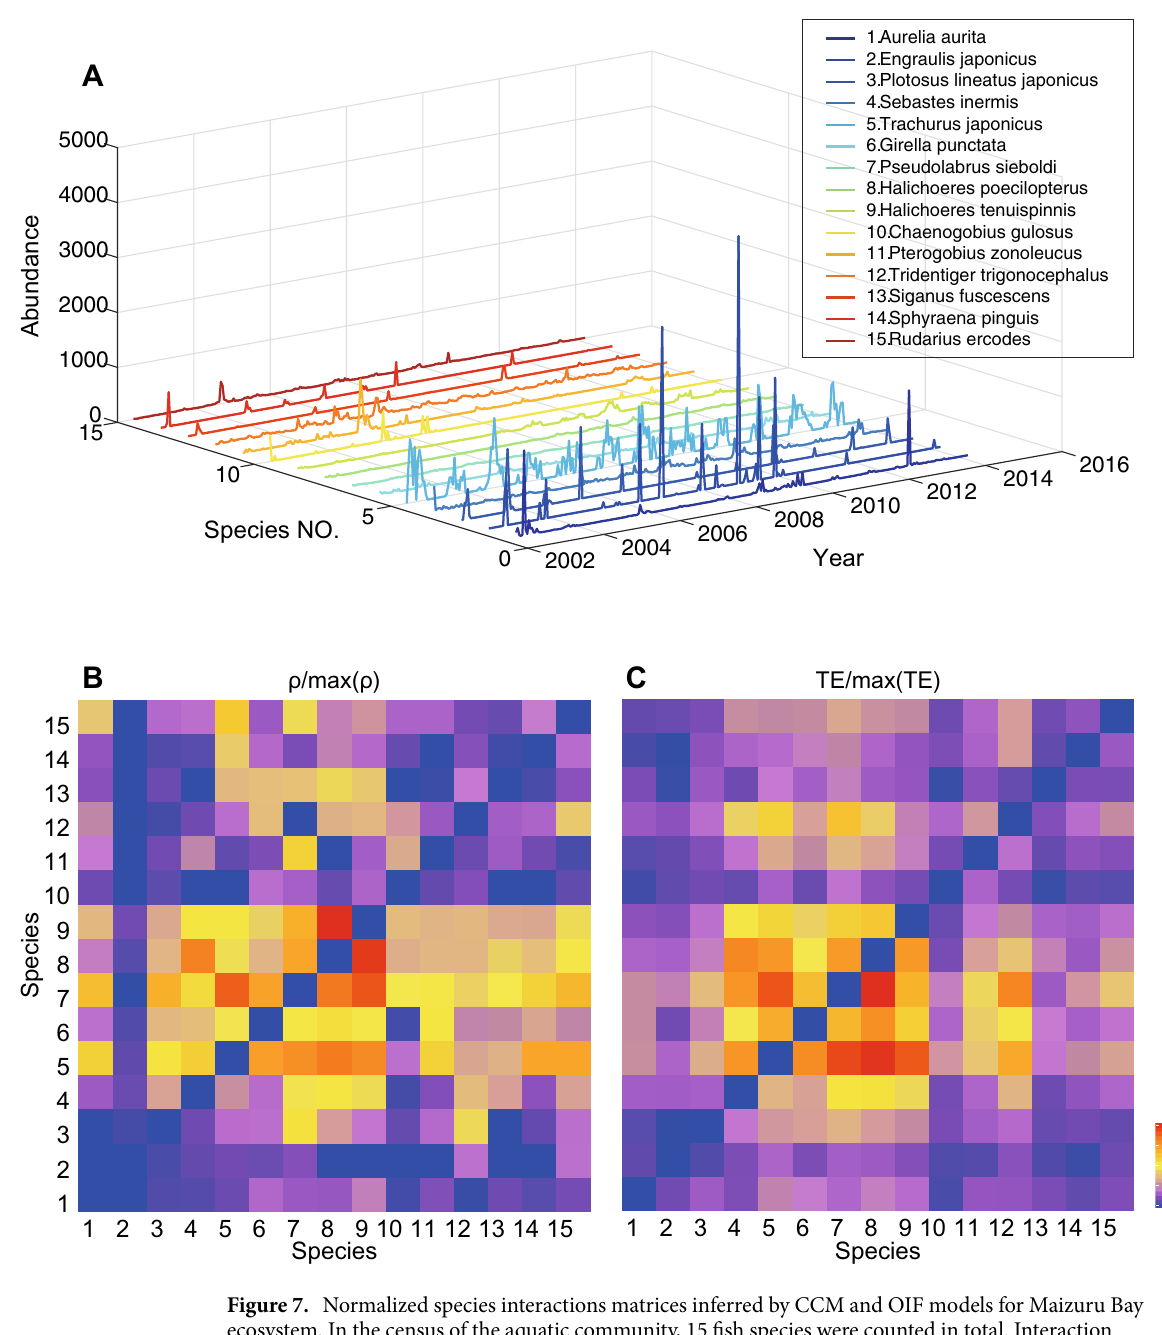
Figure 7. Normalized species interactions matrices inferred by CCM and OIF models for Maizuru Bay ecosystem. In the census of the aquatic community, 15 fish species were counted in total. Interaction inferential models use time lagged abundance magnitude (CCM) or pdfs of abundance (OIF) shown in ( A ). ( B ) normalized CCM correlation coefficients ( ρ ) between all possible pairs of species. ( C ) normalized transfer entropies (TEs) between all pairs of species from the OIF model. Both CCM and OIF predict that the most interacting species (in terms of magnitude rather than frequency) are 7, 8 and 9 on average. Thus, interaction matrices are more proportional to the asynchronicity than the divergence of species in terms of abundance pdf, although abundance value range defines the uncertainty (and diversity) for each species that ultimately affects entropy and interactions (e.g., if one species have many zero abundance instances or many equivalent values, such as species 2, TEs of that species are expected to be low due to lower uncertainty despite the asynchrony and